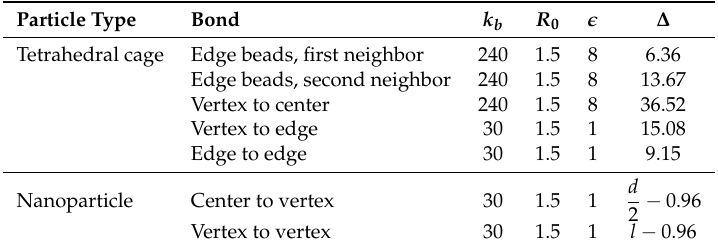
Table 1. The bond potential parameters for the tetrahedral cage and NP force sites. For the NP bonds ∆ = d /2 − 0.96, where d is NP diameter and 0.96 is the minimum of FENE potential when ∆ = 0, which insures that the minimum of bond potential is at d /2. The distance between vertices of dodecahedron is l = d /2.8, where d is the dodecahedron circumscribed sphere’s diameter. Particle